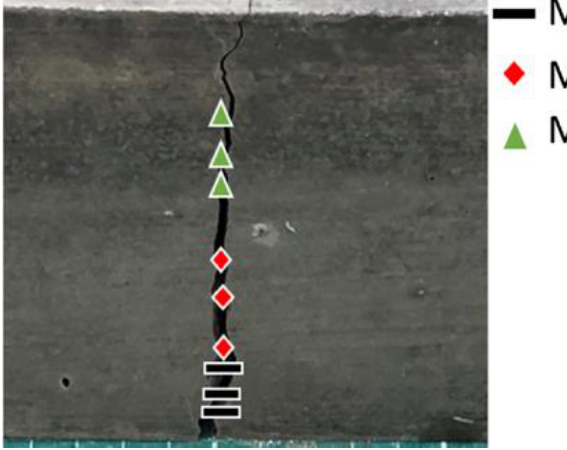
Figure 13. Physical representation of crack location trace for the SFRSCC beam.